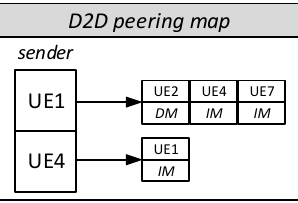
Figure 15. D2D peering map (DM: direct mode, IM: infrastructure mode).